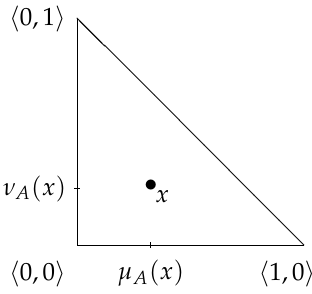
Figure 1. Geometrical interpretation of an element of an